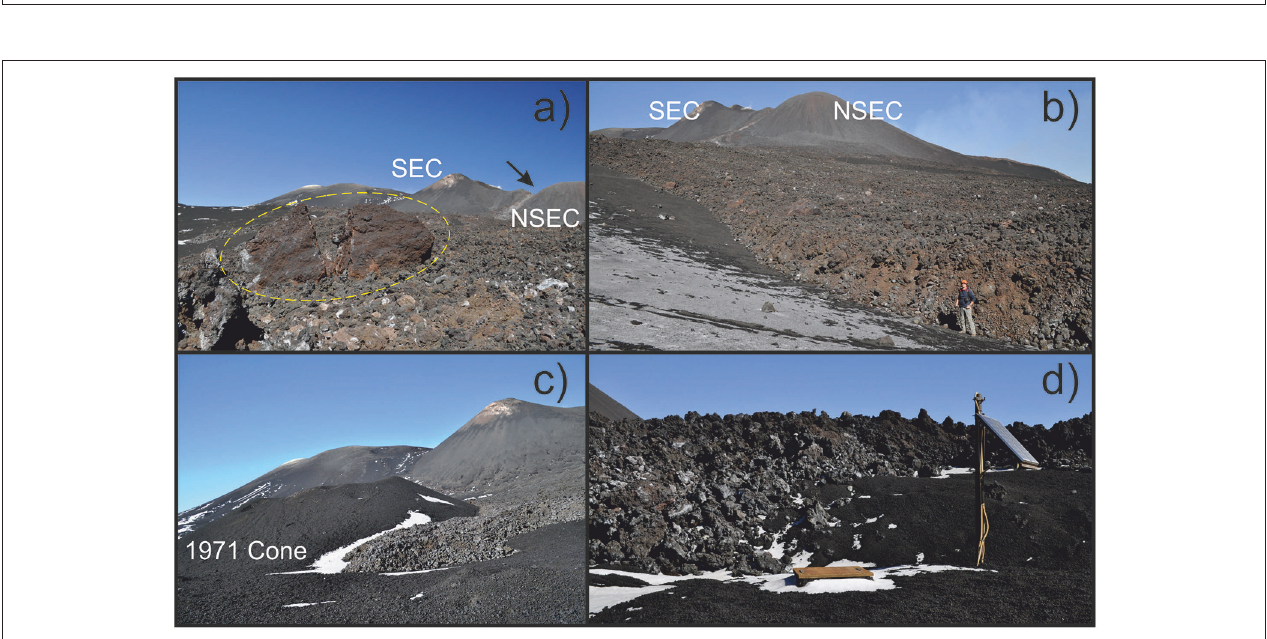
FIGURE 6 | (a) Mega-block of sub-decametric size (dotted yellow line) that collapsed from the rim crater of the NSEC and was rafted downslope by the S lava flows during the 25-26 October 2013 paroxysm. (b) The main lava flow lobe propagating toward South, in the background the peaks of the SEC and NSEC (on the left and right, respectively); see person at top right for scale; (c) the lava flow surrounding the 1971 cone; (d) the southern lava flow threating the TdF seismic station. Photos by D. Andronico.